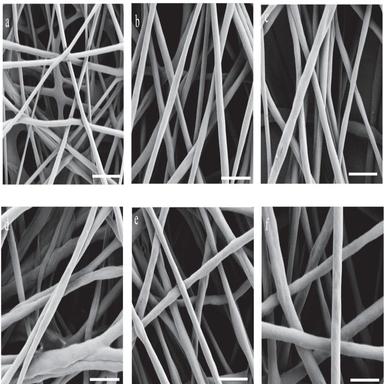
FESEM images of (a) PVA, (b) PVA/PCM and (c-f) Cross-linked PVA/PCM nanofibers prepared in different dosages of GA (c) 2.0 wt% ; (d) 6.0 wt%; (e) 8.0 wt % ; (f) 10.0 wt%. Scale bar = 2 μm.